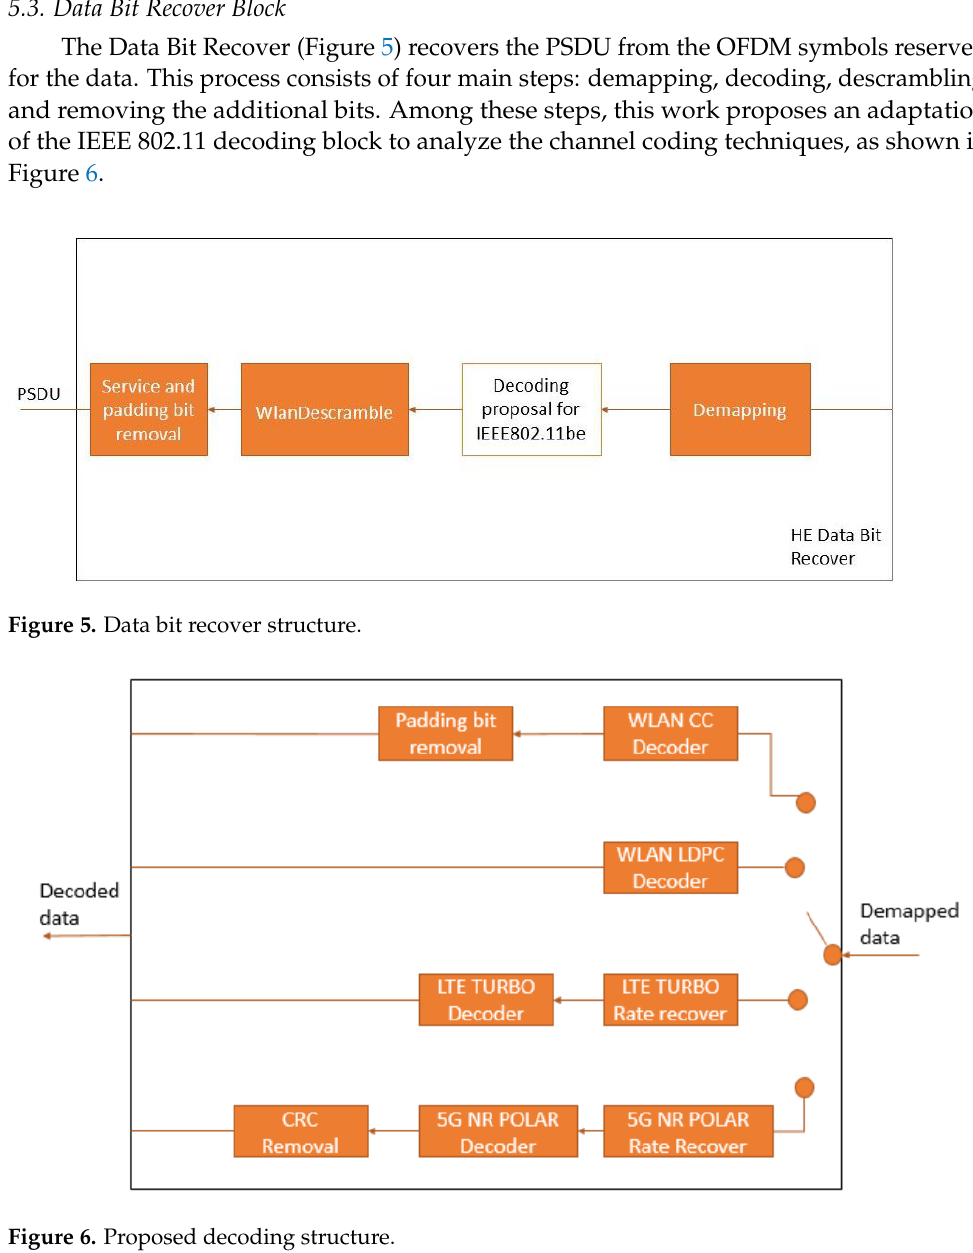
Figure 6. Proposed decoding